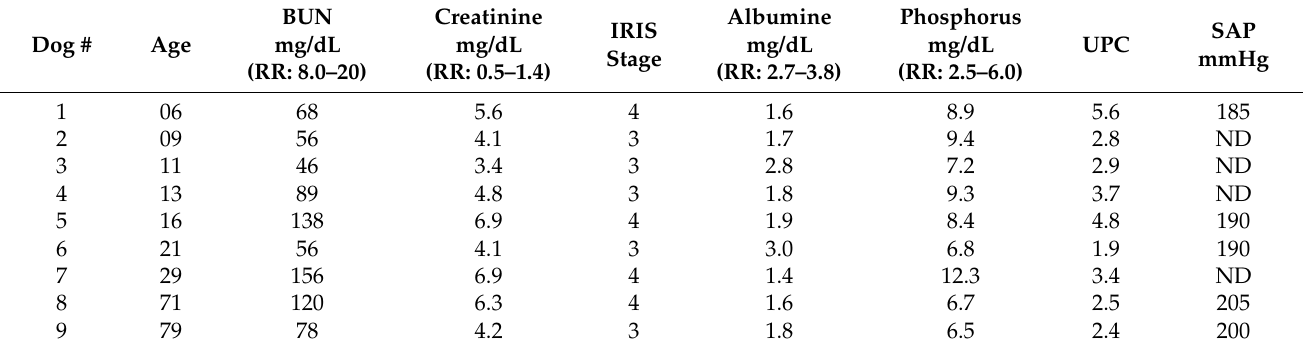
Table 1. Clinical and laboratory findings of the 9 female Boxer dogs affected by glomerular